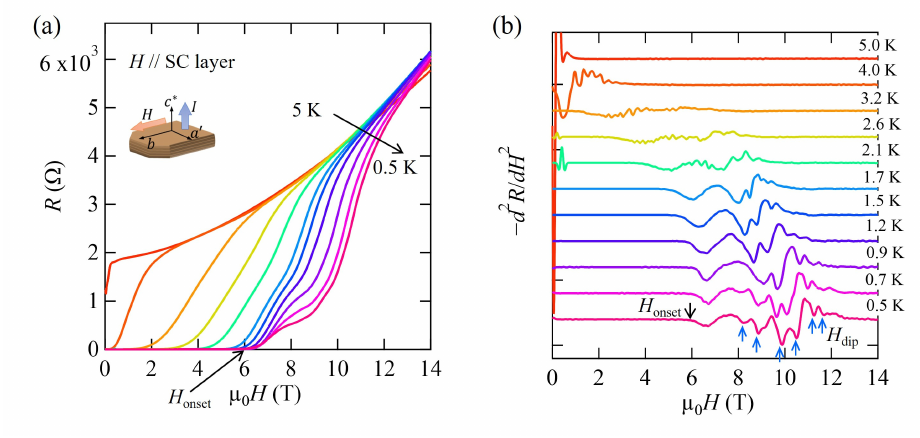
Figure 4. ( a ) Magnetic field dependence of the interlayer resistance at various temperatures. The field was applied parallel to the b axis in the superconducting a (cid:48) – b plane within an accuracy of 0.1°. ( b ) Negative second-derivative curves of the resistance. Each curve was shifted for